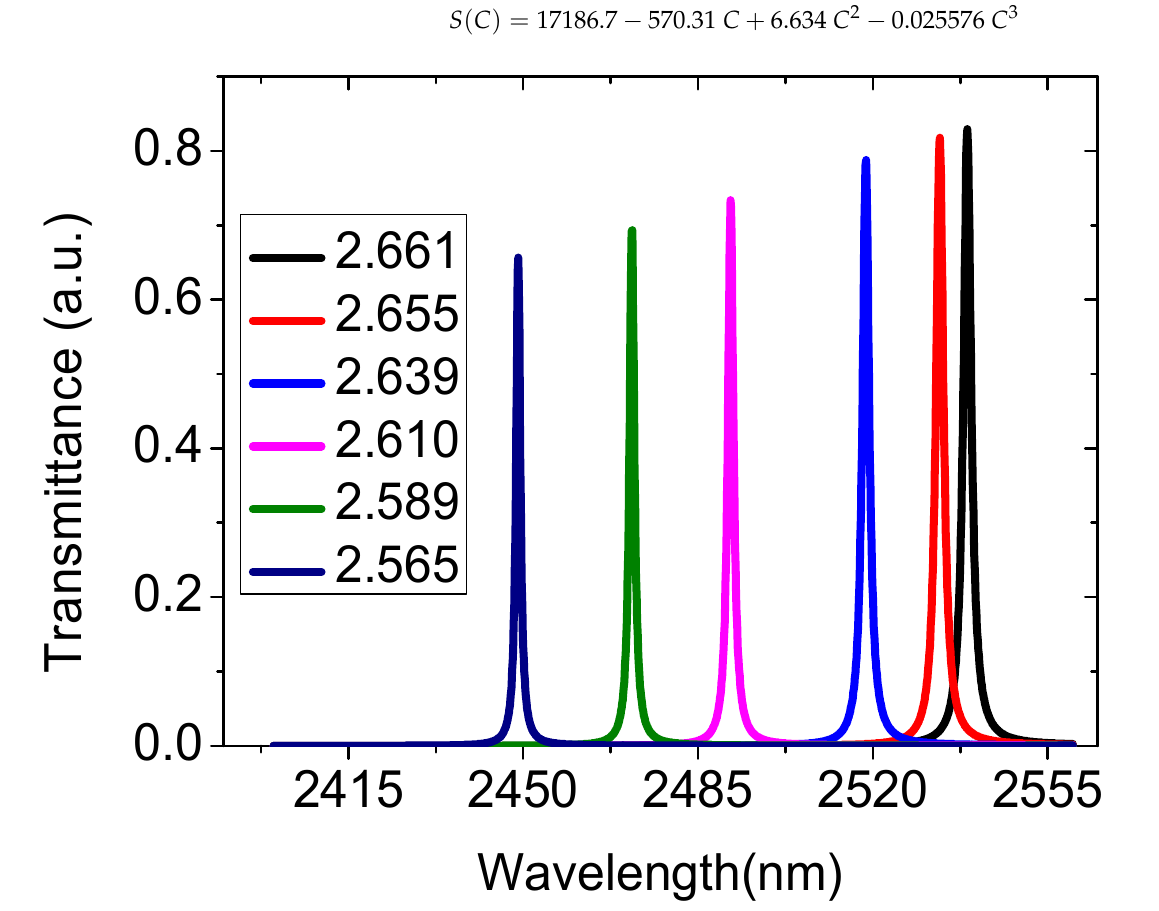
Figure 9. Transmittance spectra of the suggested TPC biosensor for various concentrations of protein at θ 0 = 60°, h f = 5.5 µm, and N = 4. Table 5. Position of resonant peak and sensitivity of different concentrations of creatinine in blood